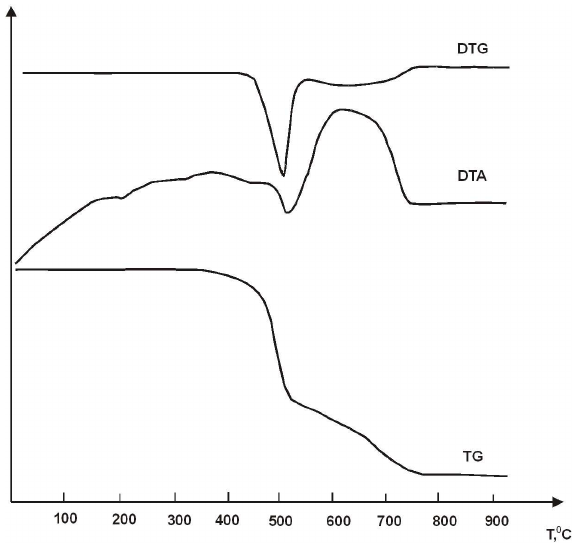
Fig. 5 Thermogram corresponding to Sample